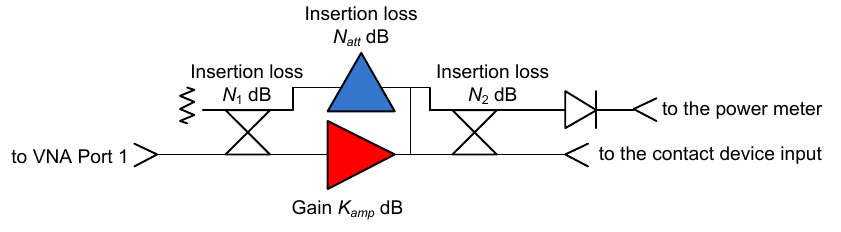
Fig. 2. The scheme of the high-level probe signal conditioning